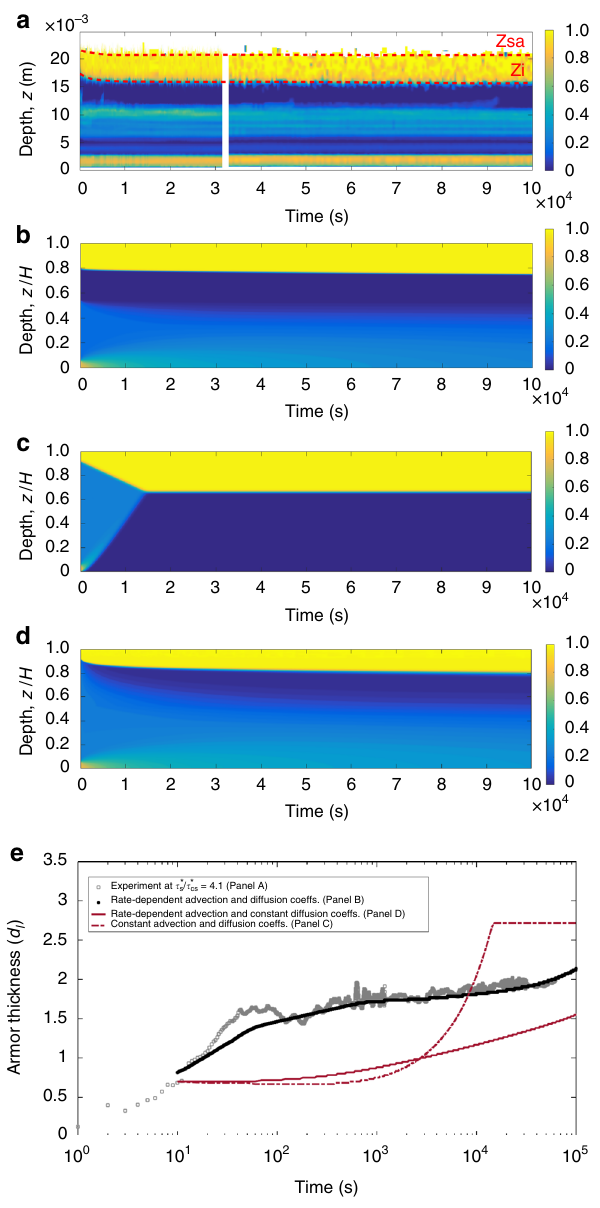
Fig. 3 Evolution of coarse grain concentration and armour through time. a 1D ( x -averaged) concentration map of large grains over time for shear stress τ (cid:1) s ¼ 4 : 1 τ (cid:1) cs . The red dashed lines show the positions of the armour surface ( z s a ) and the bottom of the armored layer ( z i ), which are used to calculate the thickness of the armored layer in Fig. 4a. b Same as a for the advection-diffusion model, using velocity pro fi les and initial conditions that correspond to the shear stress τ (cid:1) s ¼ 4 : 1 τ (cid:1) cs in a and Fig. 2. c Concentration map of large grains from the advection-diffusion model using constant advection and diffusion coef fi cients. d Concentration map of large grains from the advection-diffusion model using the experimentally-determined advection pro fi le, but a constant diffusion coef fi cient with depth. e Temporal evolution of the thickness of the armored layer at shear stress τ (cid:1) ¼ 4 : 1 τ (cid:1) s cs calculated from experimental observation corresponding to a and different implementations of the advection-diffusion